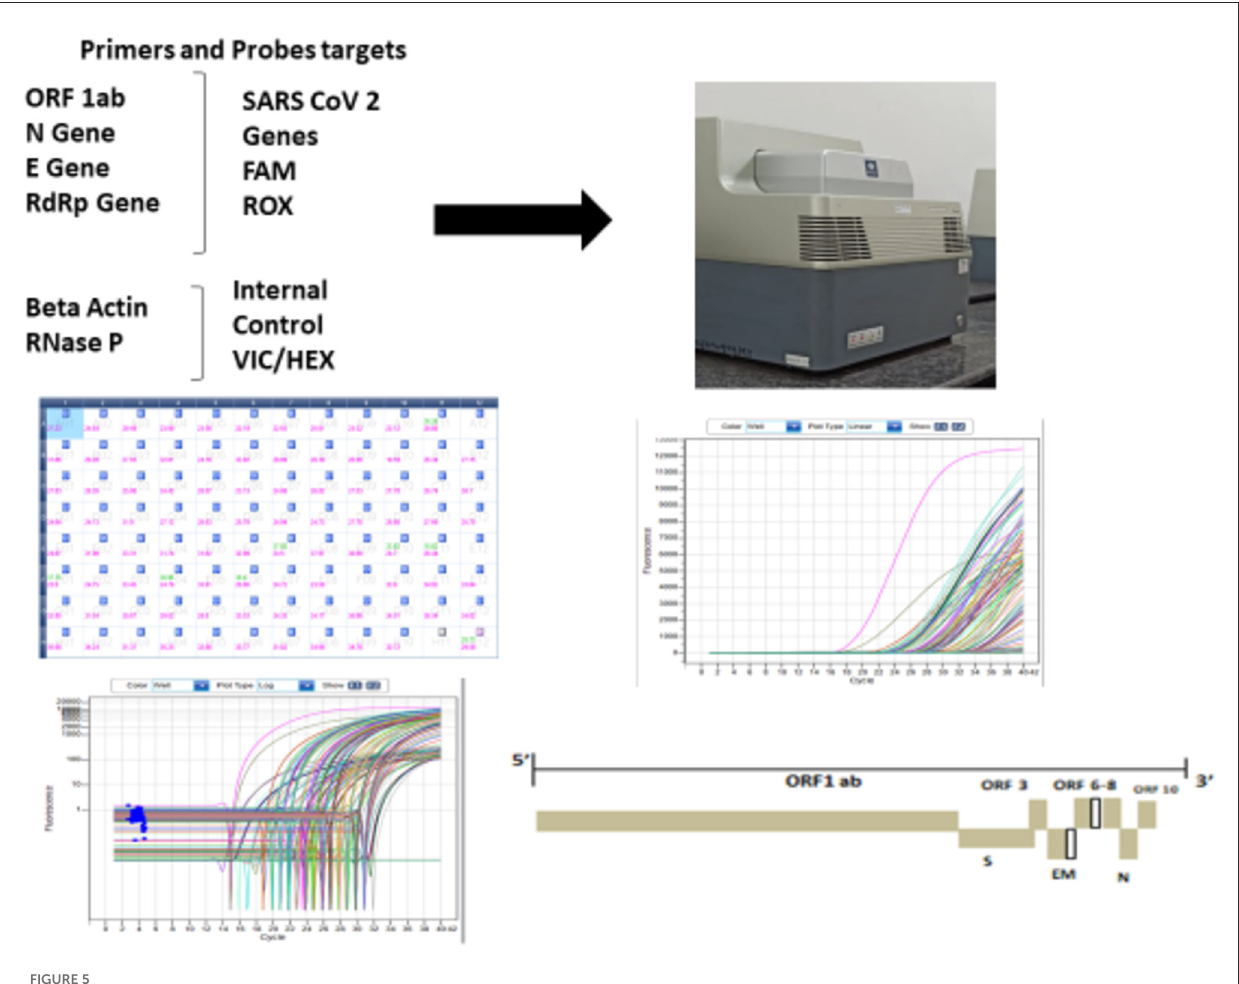
FIGURE5 Workflow of real-time PCR and data